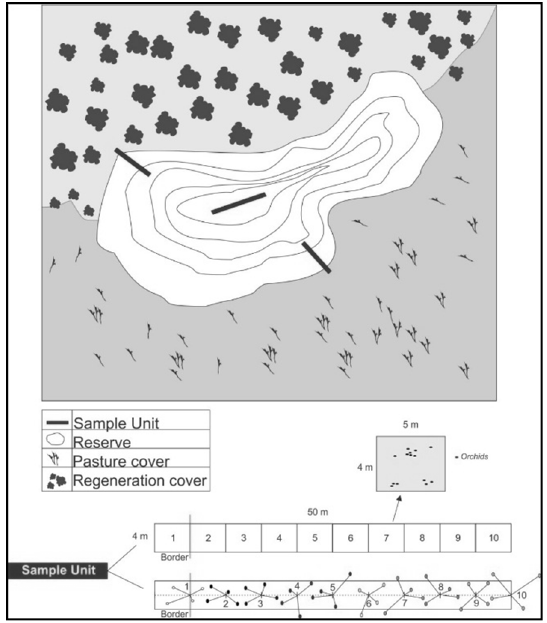
Figure 2. Scheme of the location of the sampling units in the patch, orchid and forest structure sampled method. Upper graph: representation of the distribution of the sampling units in each site. Lower graph: design of orchid inventory ( above ), and forest structure ( below ) within a sampling unit.